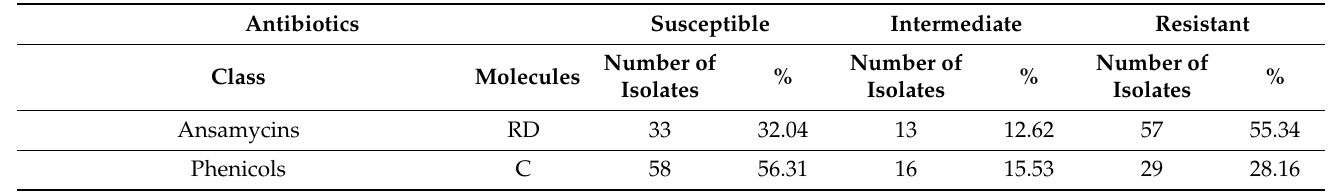
Table 1. Results obtained testing 103 Enterococcus spp. isolates versus 21 antibiotics with the agar disk diffusion